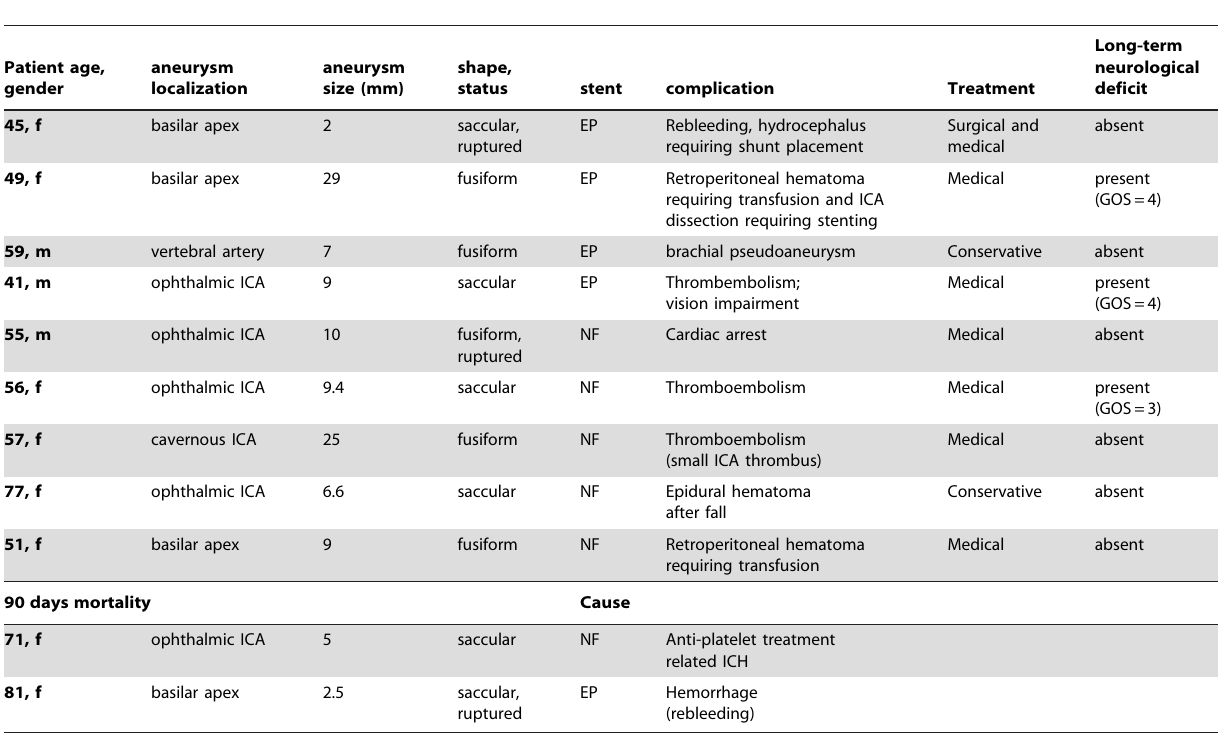
Table 3. Periprocedural mortality and major complications in patients treated in the by stent-assisted coiling.